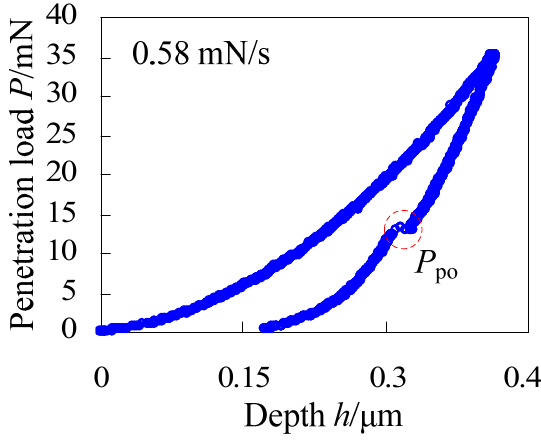
Figure 3. The load-depth curve of single crystal silicon with the maximum penetration load of 35 mN and the loading/unloading rate of 0.58